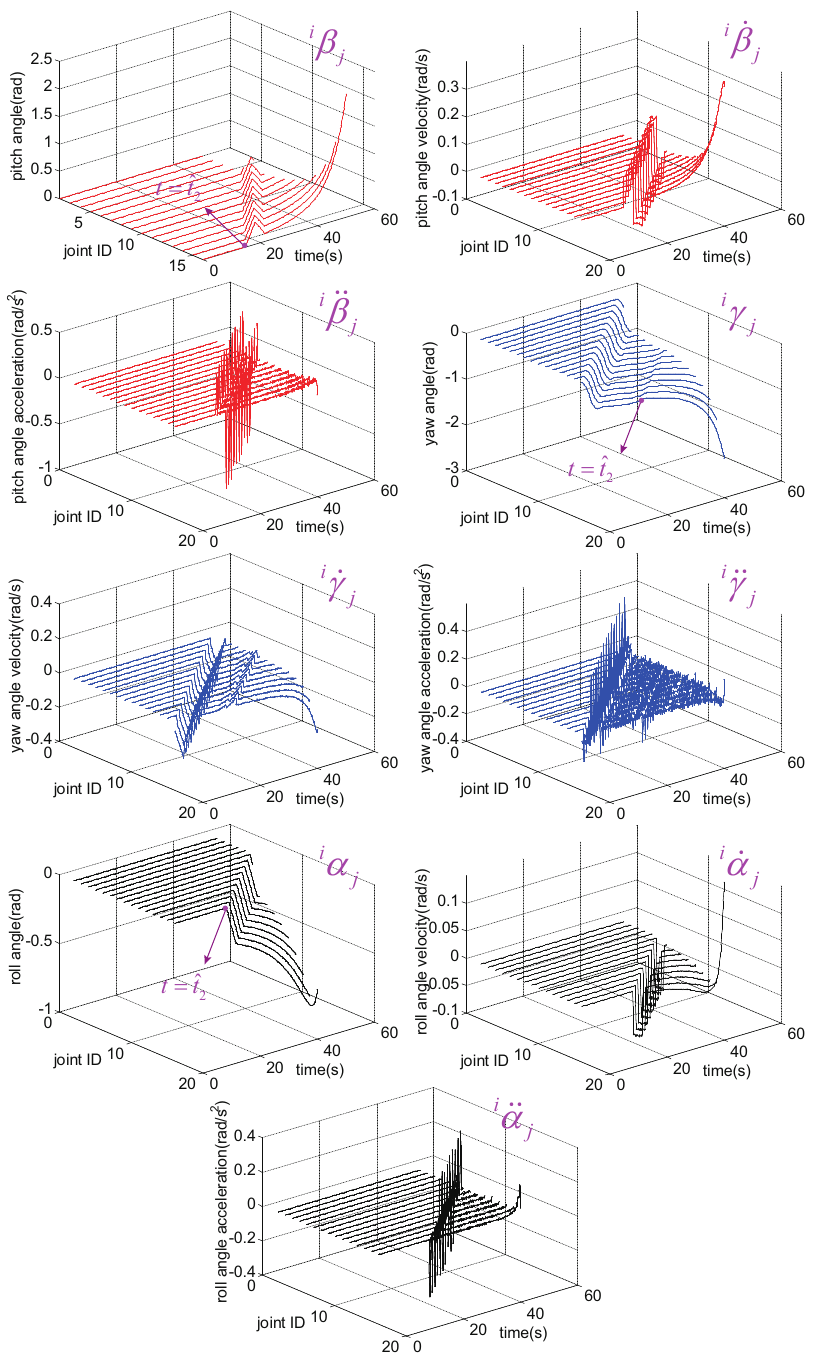
Figure 10. Angle, angular velocity, and angular acceleration during phase-shifting